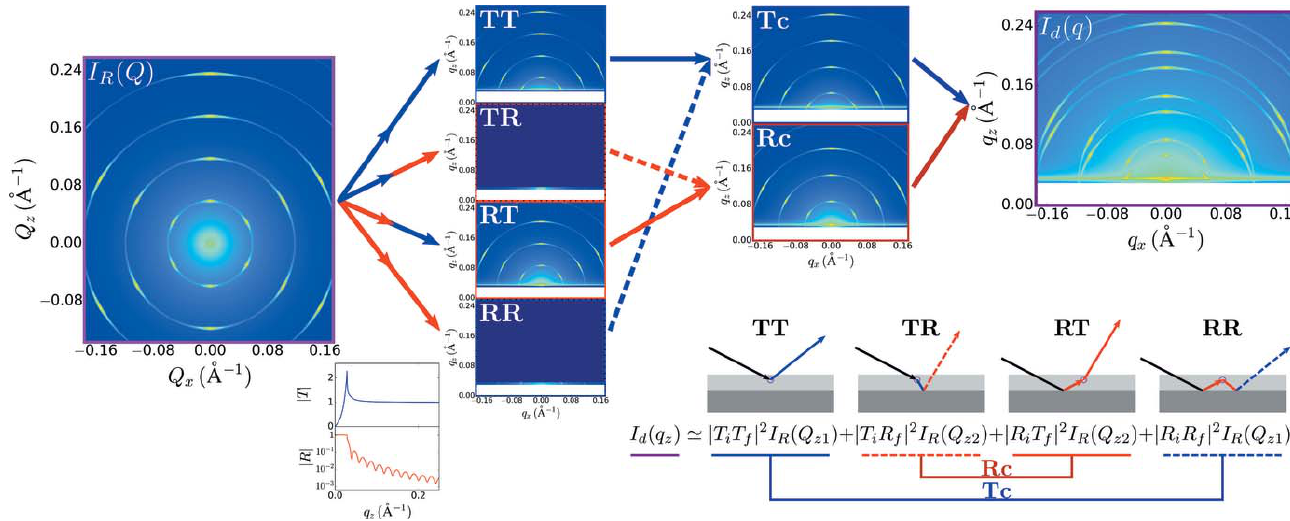
Figure 4 Graphical representation of the distorted-wave Born approximation (DWBA) used to calculate the total scattering intensity in a GISAXS experiment. The DWBA has four terms (TT, TR, RT and RR) which can be understood in terms of the four most probable configurations for a scattering event. The scattering amplitude from these four terms interfere coherently; to a good approximation their intensity contributions are simply additive. The four scattering terms can be grouped into two scattering channels: one where the scattering pattern is centered about the transmitted beam ( Tc channel) and one where the scattering is centered about the reflected beam ( Rc channel). The summation of these two channels yields the measured detector image ð q Þ ], accounting for the doubling, shift and distortion of the scattering patterns observed in [ I d